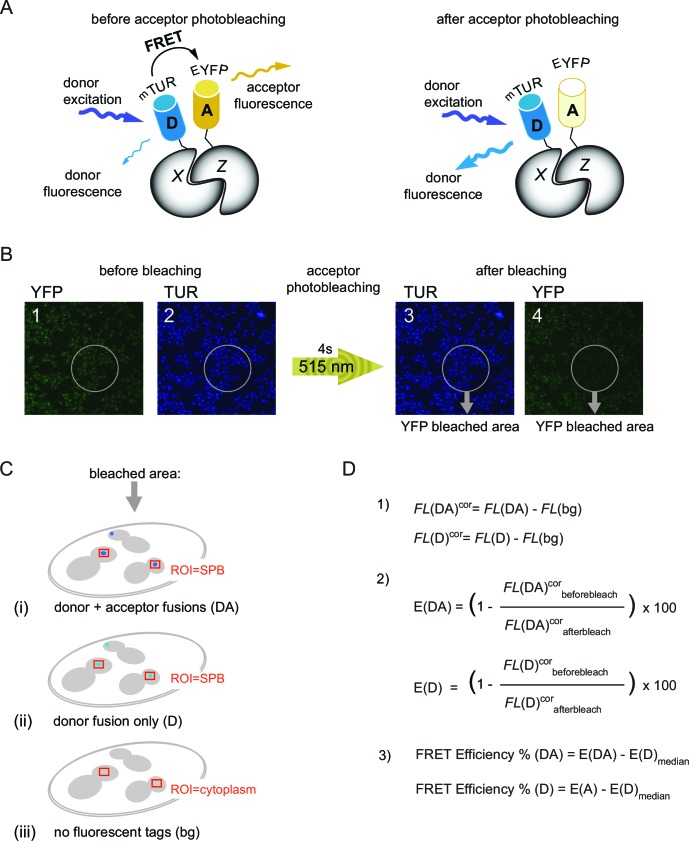
The basic principles of acceptor photobleaching technique to measure FRET.(A) Schematic representation of FRET between D-donor (mTUR - turquoise fluorescent protein tagged with host protein X) and A-acceptor (EYFP - yellow fluorescent protein tagged with host protein Z). Note that donor fluorescence increases after photobleaching of the acceptor. (B) Experimental setup to measure FRET. The order of image acquisition is indicated from 1 to 4 and the region of photobleaching within the sample field is delineated by grey circles. 515 nm: laser wavelength used for YFP photobleaching. (C) FRET for each protein pair tagged with mTUR and EYFP was calculated using mean fluorescence intensities of three samples: (DA) – with donor and acceptor tagged protein pair (i), (D) - with donor only tag (ii), (bg) - no tag (iii). Fluorecence intensities of donor fluorescence were measured from regions around SPBs indicated with red squares. For untagged cells, a region within the cytoplasm was measured (used for background correction of the signal intensities). (D) Equations used for quantification of FRET efficiency: (1) background correction of the mean fluorescence intensities (FL) where FL(DA), FL(D), FL(bg) are the raw values of mean fluorescence intensities of the donor and acceptor (DA), the donor only (D) and untagged (bg) samples described in Figure 1—figure supplement 1C. FLcor: background corrected values. (2) Calculation of percentage increase in FLcor after acceptor photobleaching for the donor and acceptor pair [E(DA)] and for the donor only control [E(DA)]. (3) Normalization of the E(DA) and E(D) values to the median of E(D) [E(D)median] to obtain the 'FRET efficiency%' shown in the box-whisker plots. FRET for each pair was recognized as positive if the 'FRET efficiency% (DA)' was significantly higher than the 'FRET efficiency% (D)' according to student´s t-test with (p<0.01).